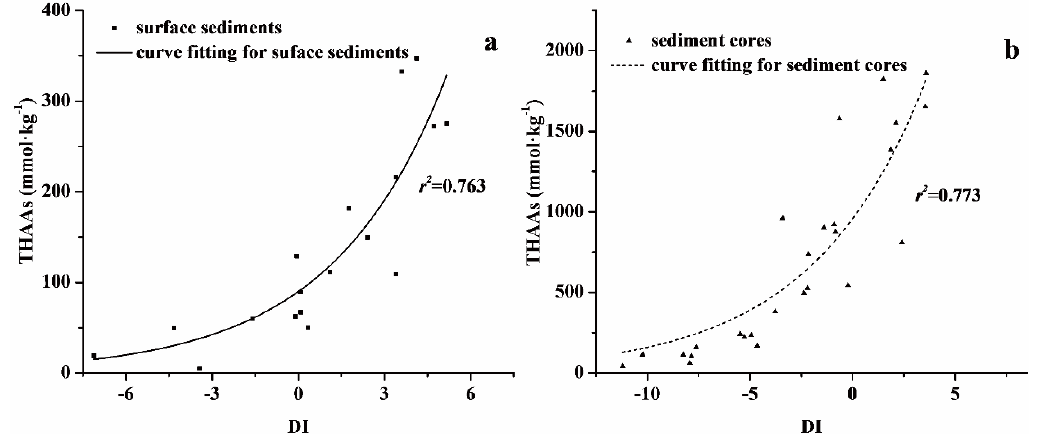
Figure 6. Relationship between THAAs and DI in ( a ) surface sediments and ( b ) sediment cores of the Ziya River Watershed.